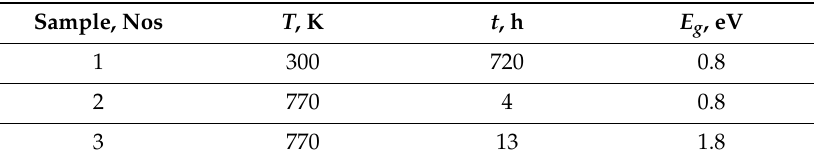
Table 1. Results of E g measurements for various oxidation conditions. T is the annealing temperature, t is the annealing duration of the sample in oxygen, E g is the most probable band gap energy under the selected oxidation conditions.